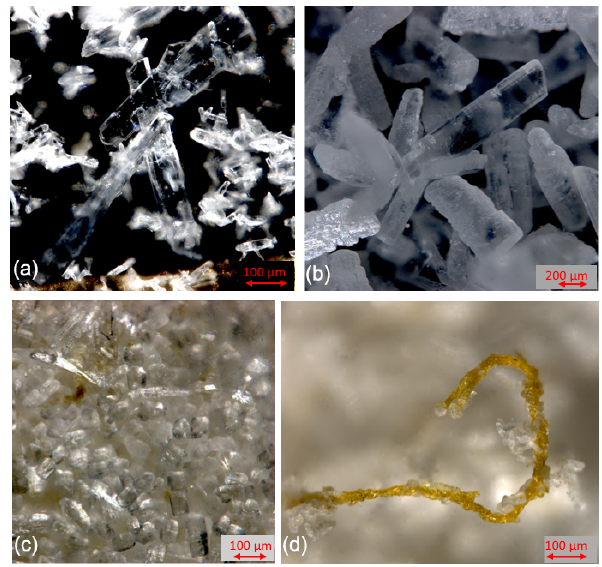
Figure 2. Cryogenic gypsum crystals collected during Polarstern expedition PS106/1 from the upper water column. (a) Crystals col- lected from station 66 at 5m water depth. (b) Crystals collected from station 66 at 0m water depth. (c) Crystals collected from sta- tion 45 at 10m water depth. (d) Crystals collected from station 45 at 10m water depth entangled in an algae